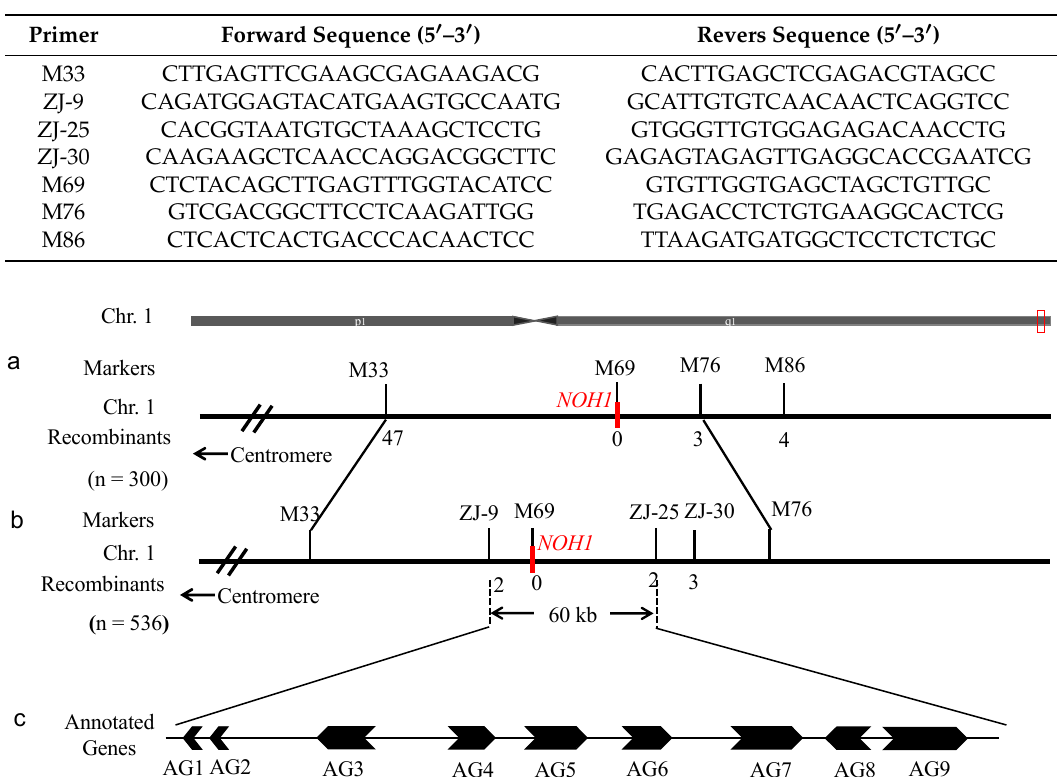
Table 1. Polymorphic markers for gene mapping.